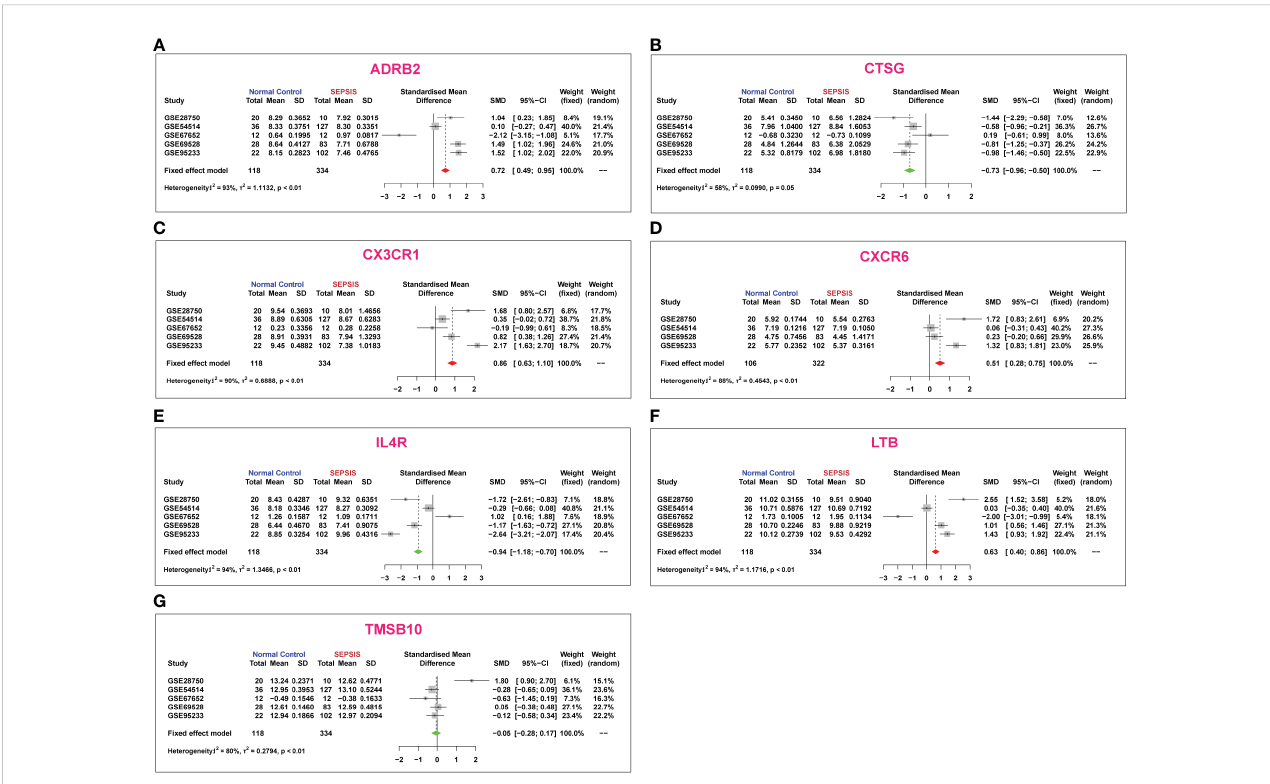
FIGURE 3 Meta-analysis of immune gene expression in sepsis based on existing microarray data sets: (A) ADRB2, (B) CTSG, (C) CX3CR1, (D) CXCR6, (E) IL4R, (F) LTB, and (G) TMSB10.